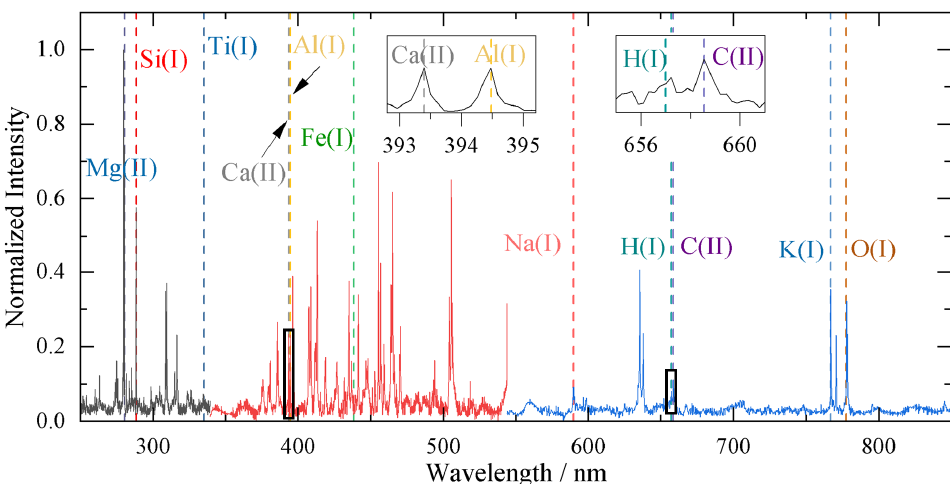
Figure 3. Example of a LIBS spectrum from feldspathic quartz sandstone (SDU-001-SEC). The emission lines of eleven elements (Si, Fe, Mg, K, Na, Ti, Ca, Al, O, H, and C) were identified based on the NIST database [22]. The black, red, and blue segments are corresponding to the three spectral channels.